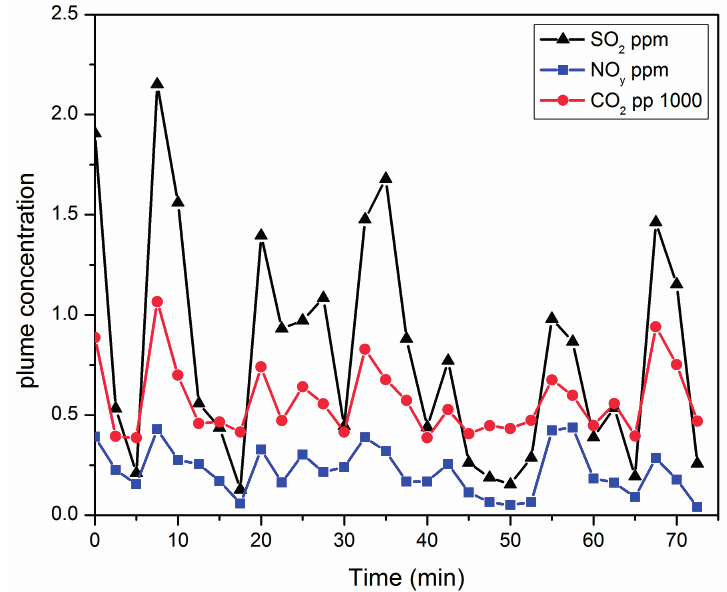
Figure 8. “Background corrected” concentrations of SO the airship’s sampling system during the “close-in” sampling run on 28